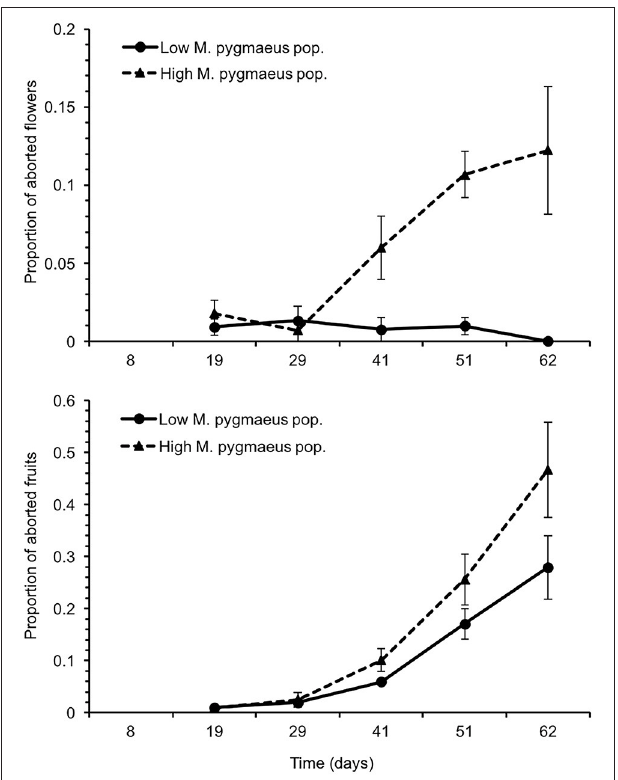
FIGURE 5 | Total yield (upper graph) and fruit weight (lower graph) ± SE in tomato greenhouses with low and high M. pygmaeus